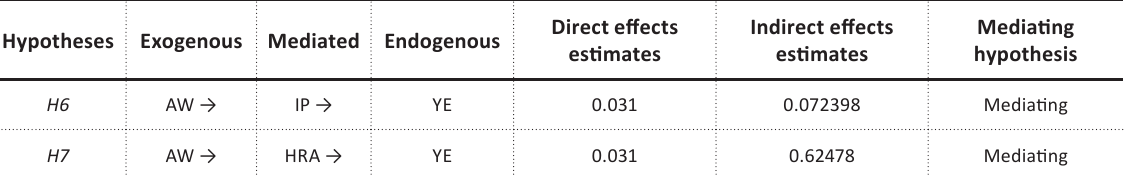
Table 5. Mediation